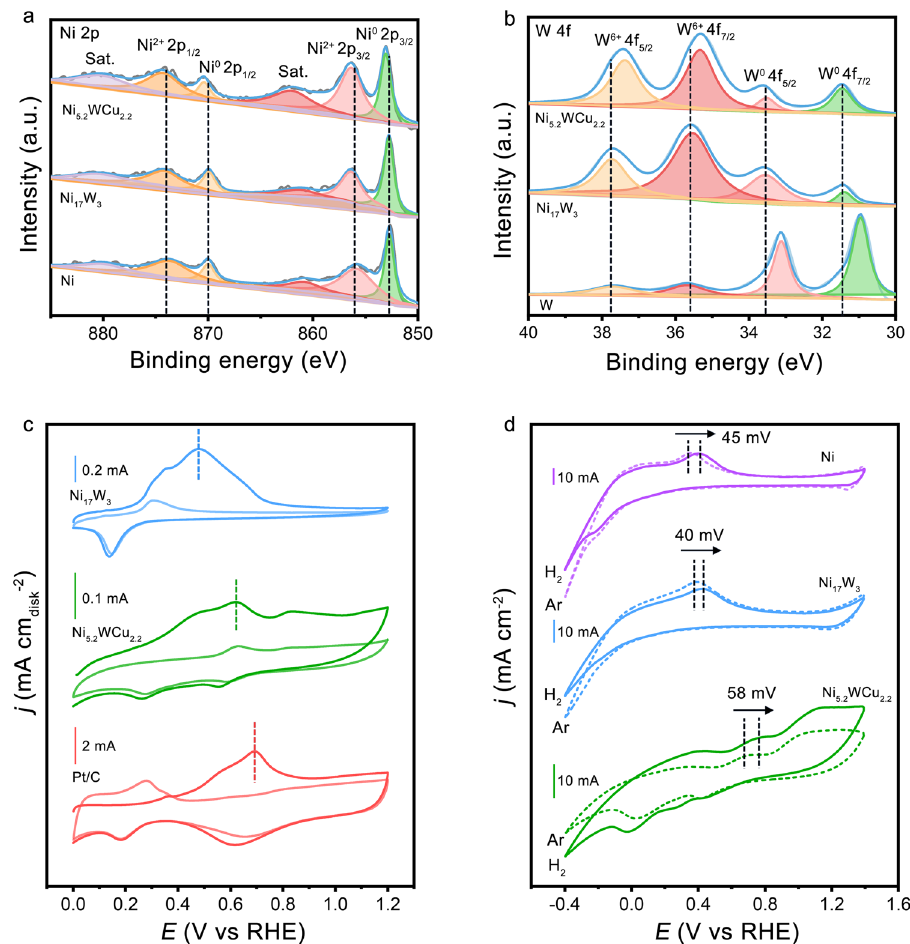
Fig. 4 Surface analysis of different catalysts. a Ni 2 p XPS spectra of Ni 5.2 WCu 2.2 , Ni 17 W 3 , and Ni. b W 4 f XPS spectra of Ni 5.2 WCu 2.2 , Ni 17 W 3 , and W. c CO-stripping measurements on Ni 5.2 WCu 2.2 , Ni 17 W 3 , and Pt/C catalyst in 0.1 M KOH electrolyte. Scan rate: 20 mV s − 1 . Rotation speed: 1600 r.p.m. The light-colored curves in c show the second cycle of the measurements. d CV curves of Ni 5.2 WCu 2.2 , Ni 17 W 3 , and Ni in H 2 - and Ar-saturated 0.1 M KOH, respectively. Scan rate: 50 mV s − 1